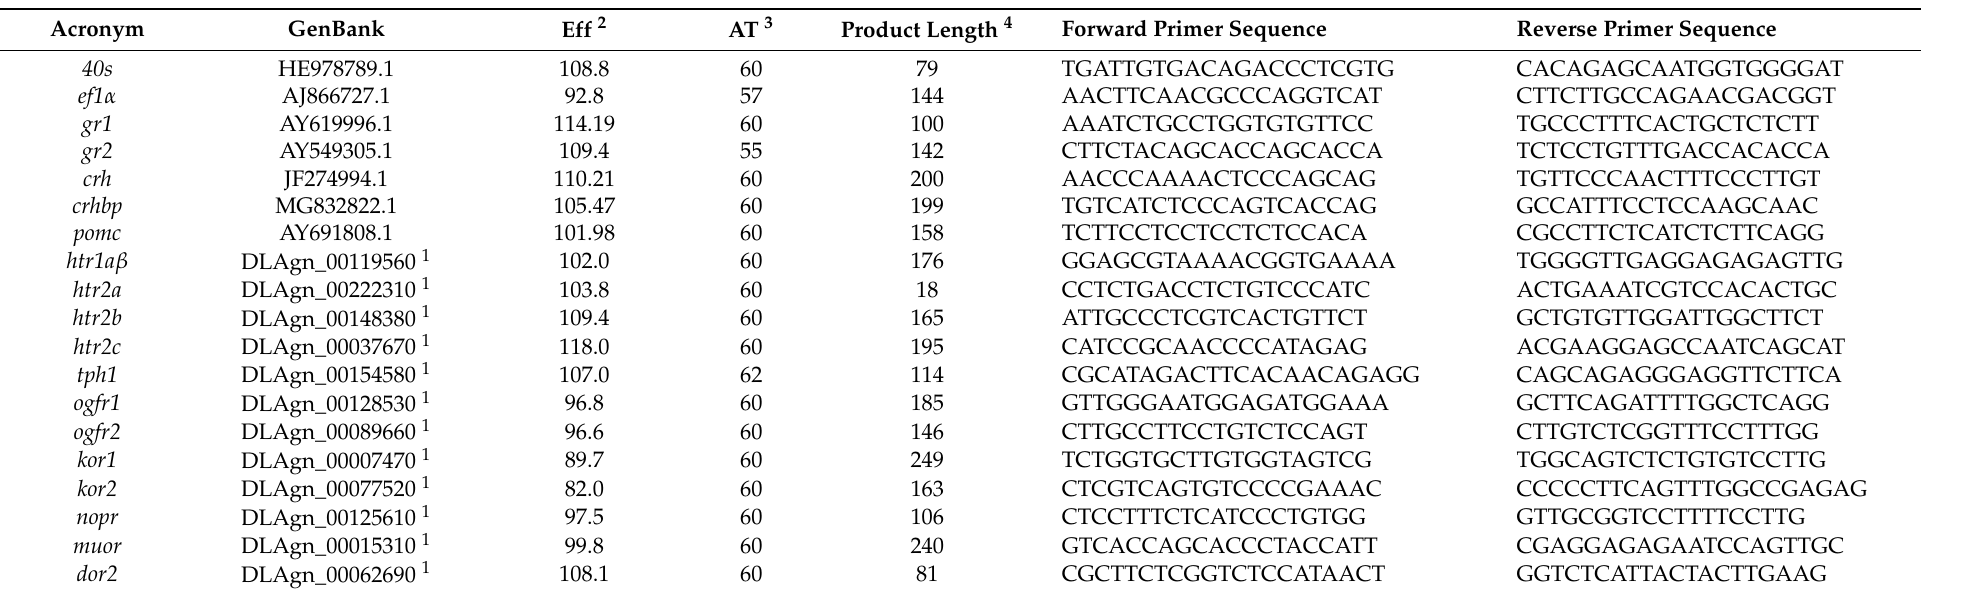
Table 1. Forward and reverse primers for real-time